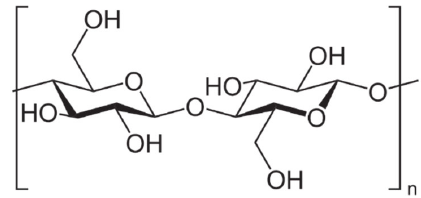
Figure 1. Cellulose chain repeating unit.